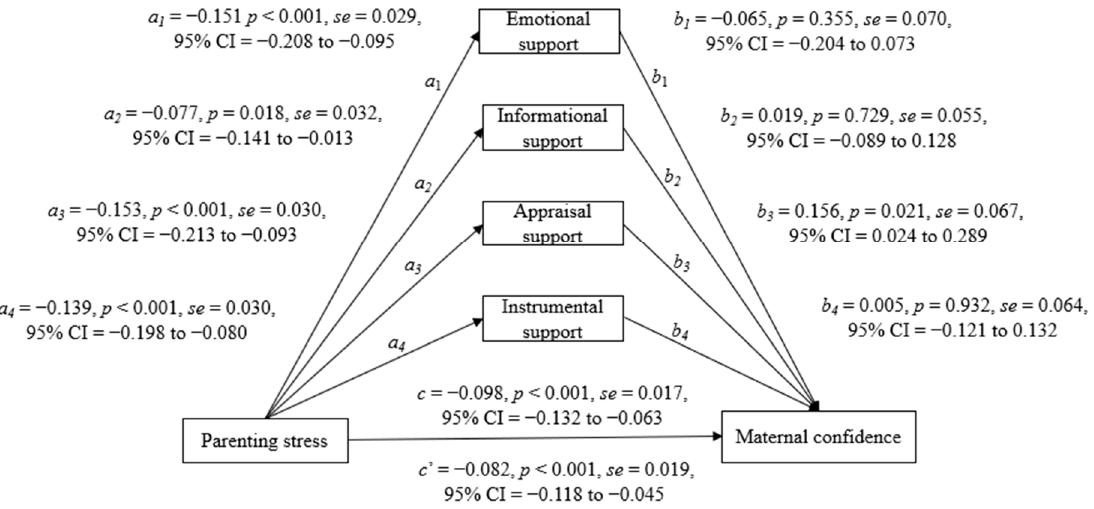
Figure 3. Effects of parenting stress on maternal confidence with the mediator of types of social support, adjusted for infant age by month ( N = 205).